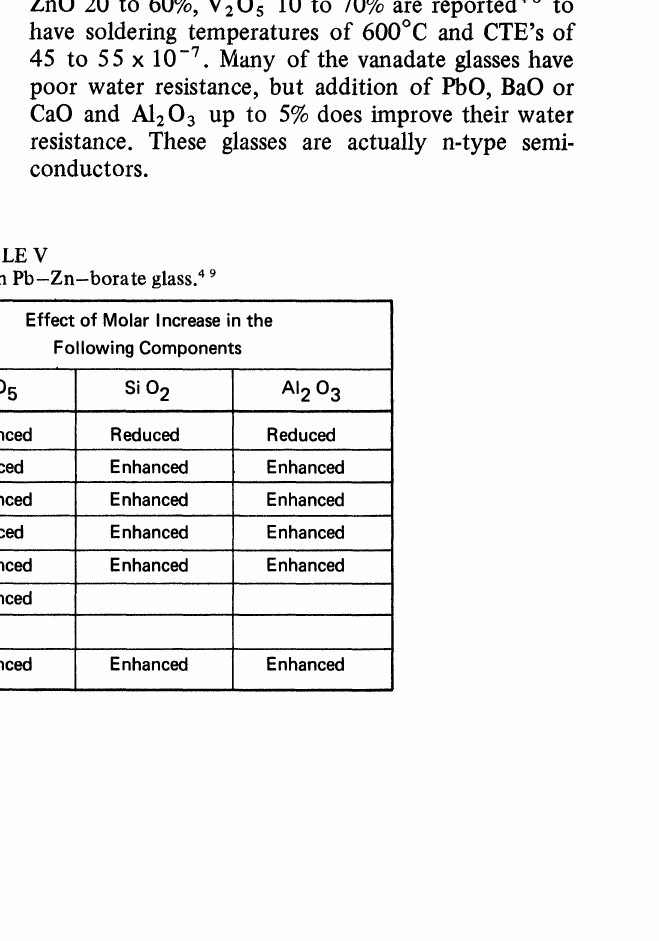
TABLE V Effect of composition in Pb-Zn-borate glass.